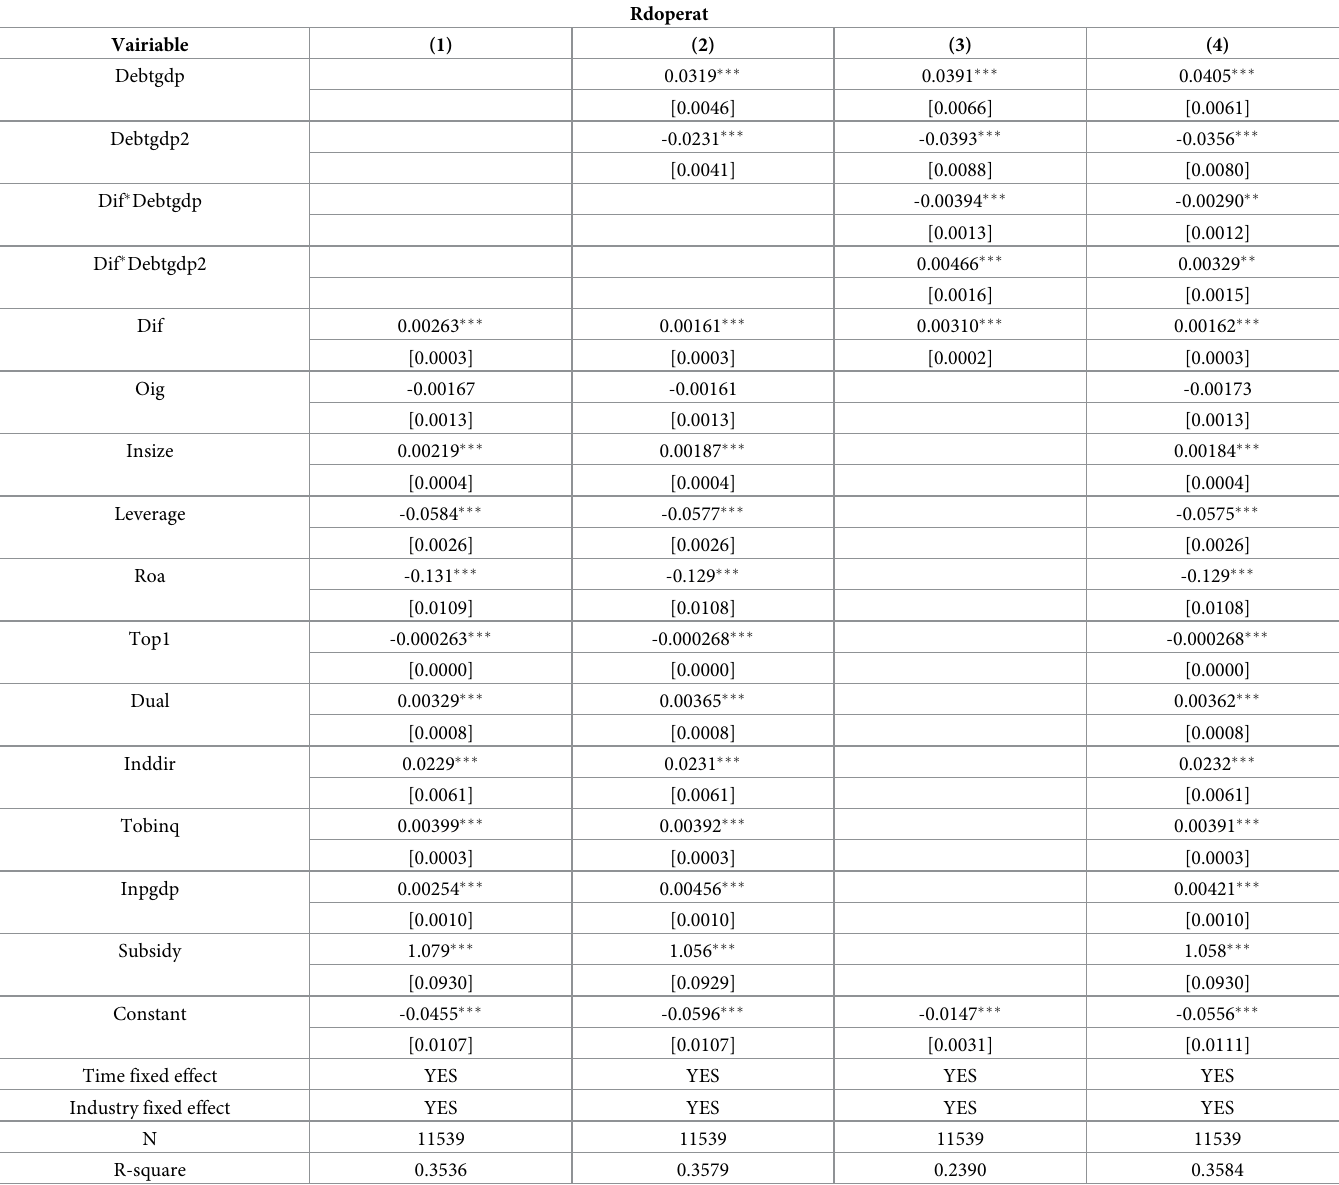
Table 8. Regression results of digital finance as the mediating